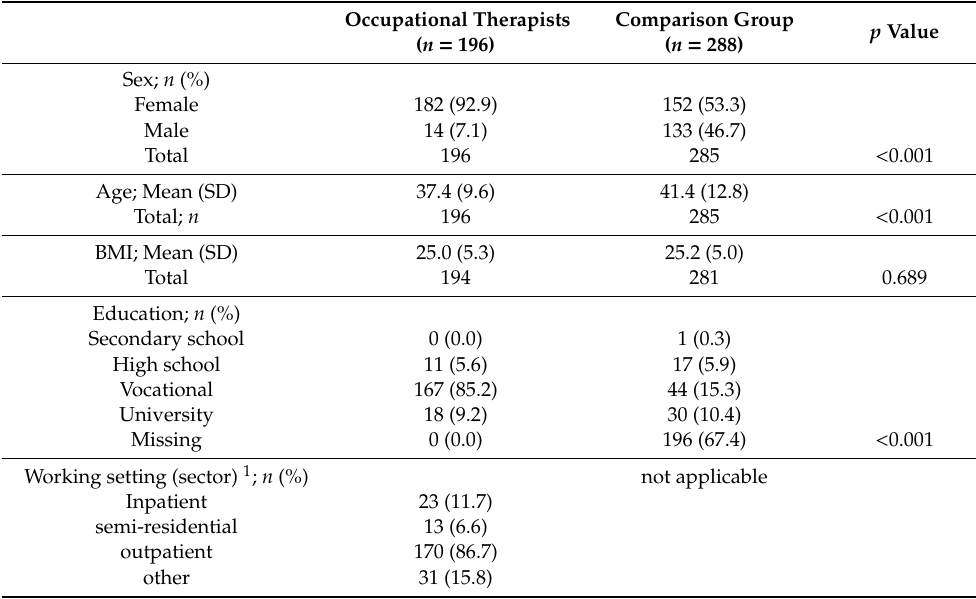
Table 1. Sociodemographic characteristics of the study population (total: n =